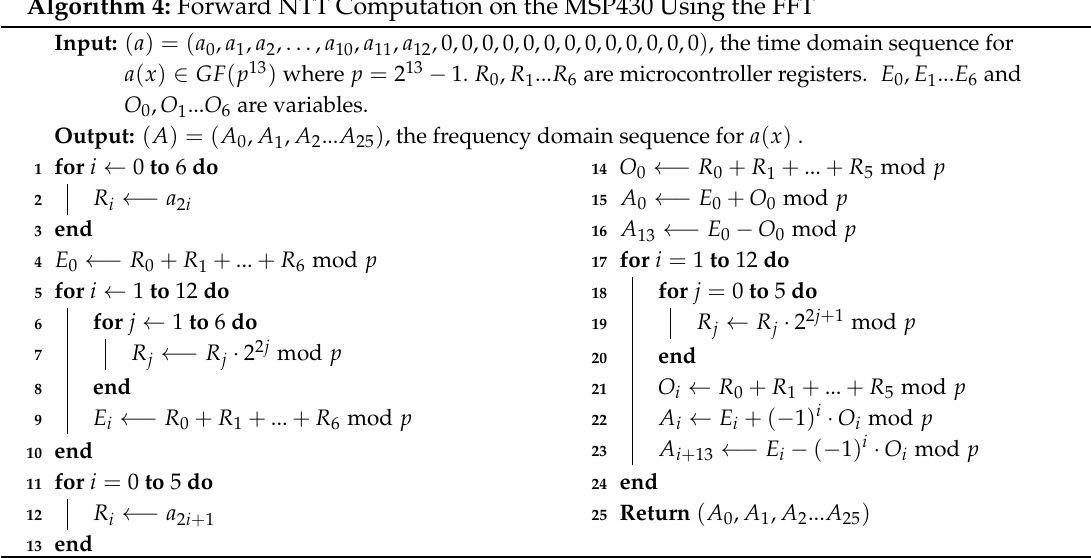
Algorithm 4: Forward NTT Computation on the MSP430 Using the